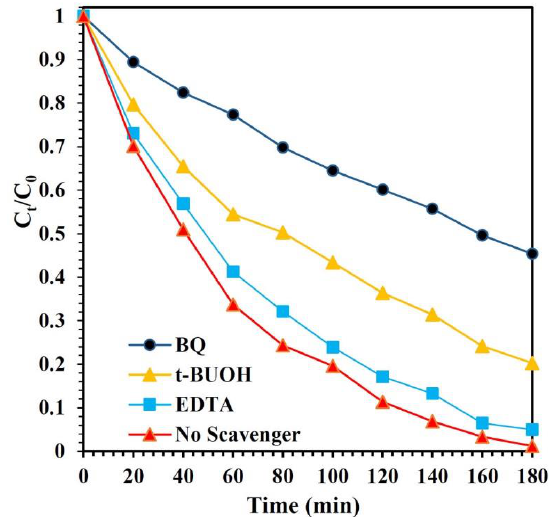
Fig. 7. Activities of ZnO-Cu2O nanocomposite for the visible light photocat- alytic decomposition of Paraoxon in the existence of various